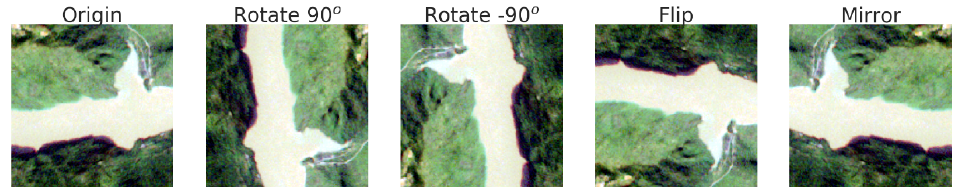
Figure 6. Training images’ augmentation result after rotating, flipping, and